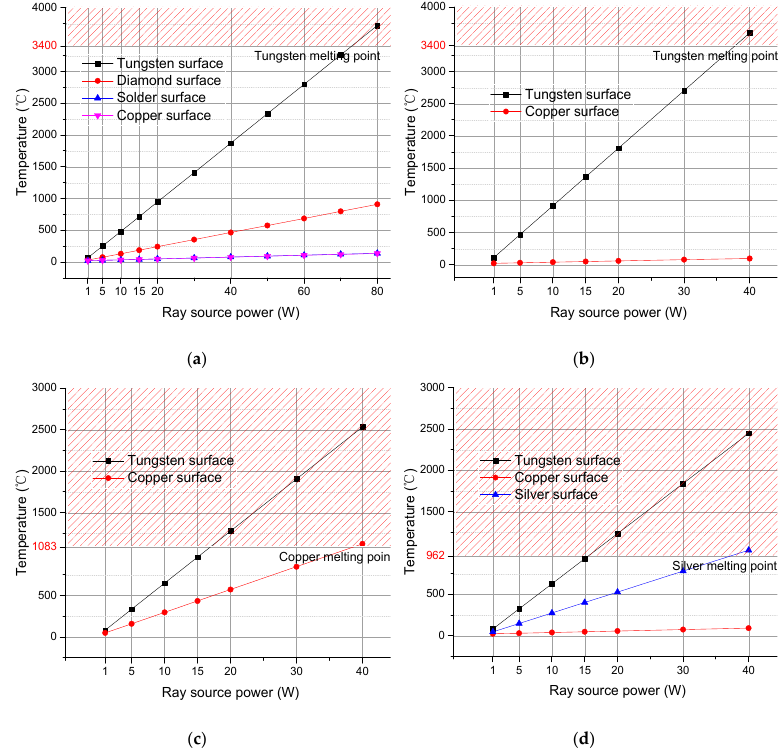
Figure 9. Maximum temperatures in each layer at different powers for four types of anodes: ( a ) diamond composite anode; ( b ) conventional tungsten anode; ( c ) tungsten film anode; ( d ) anode with silver heat buffer layer.